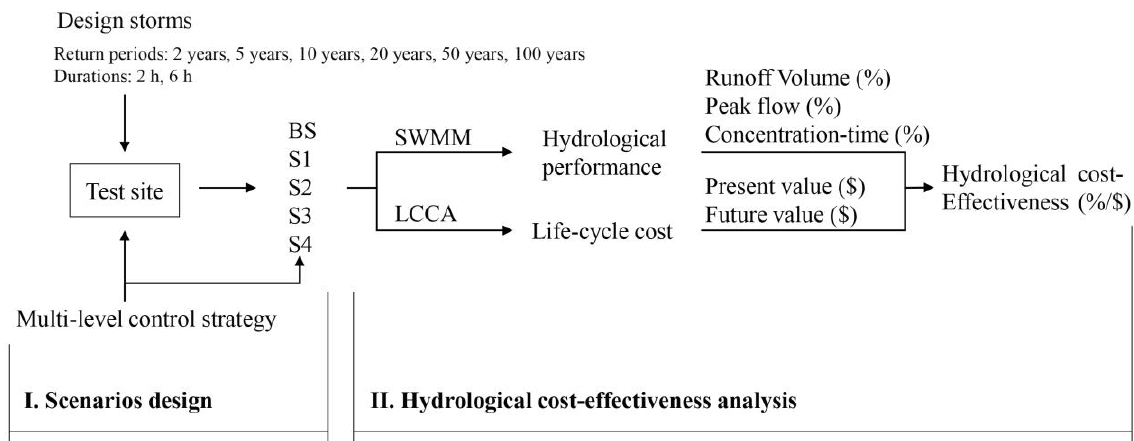
Figure 1. The framework of hydrological cost-effectiveness.